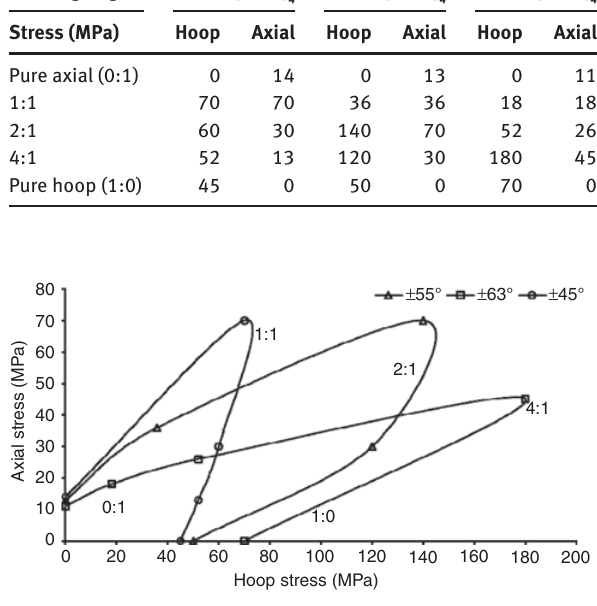
Figure 12: First ply failure envelope for pipes with winding angles of [ ± 45 ° ] , [ ± 55 ° ] , and [ ± 63 ° ] at five stress 4 4 4